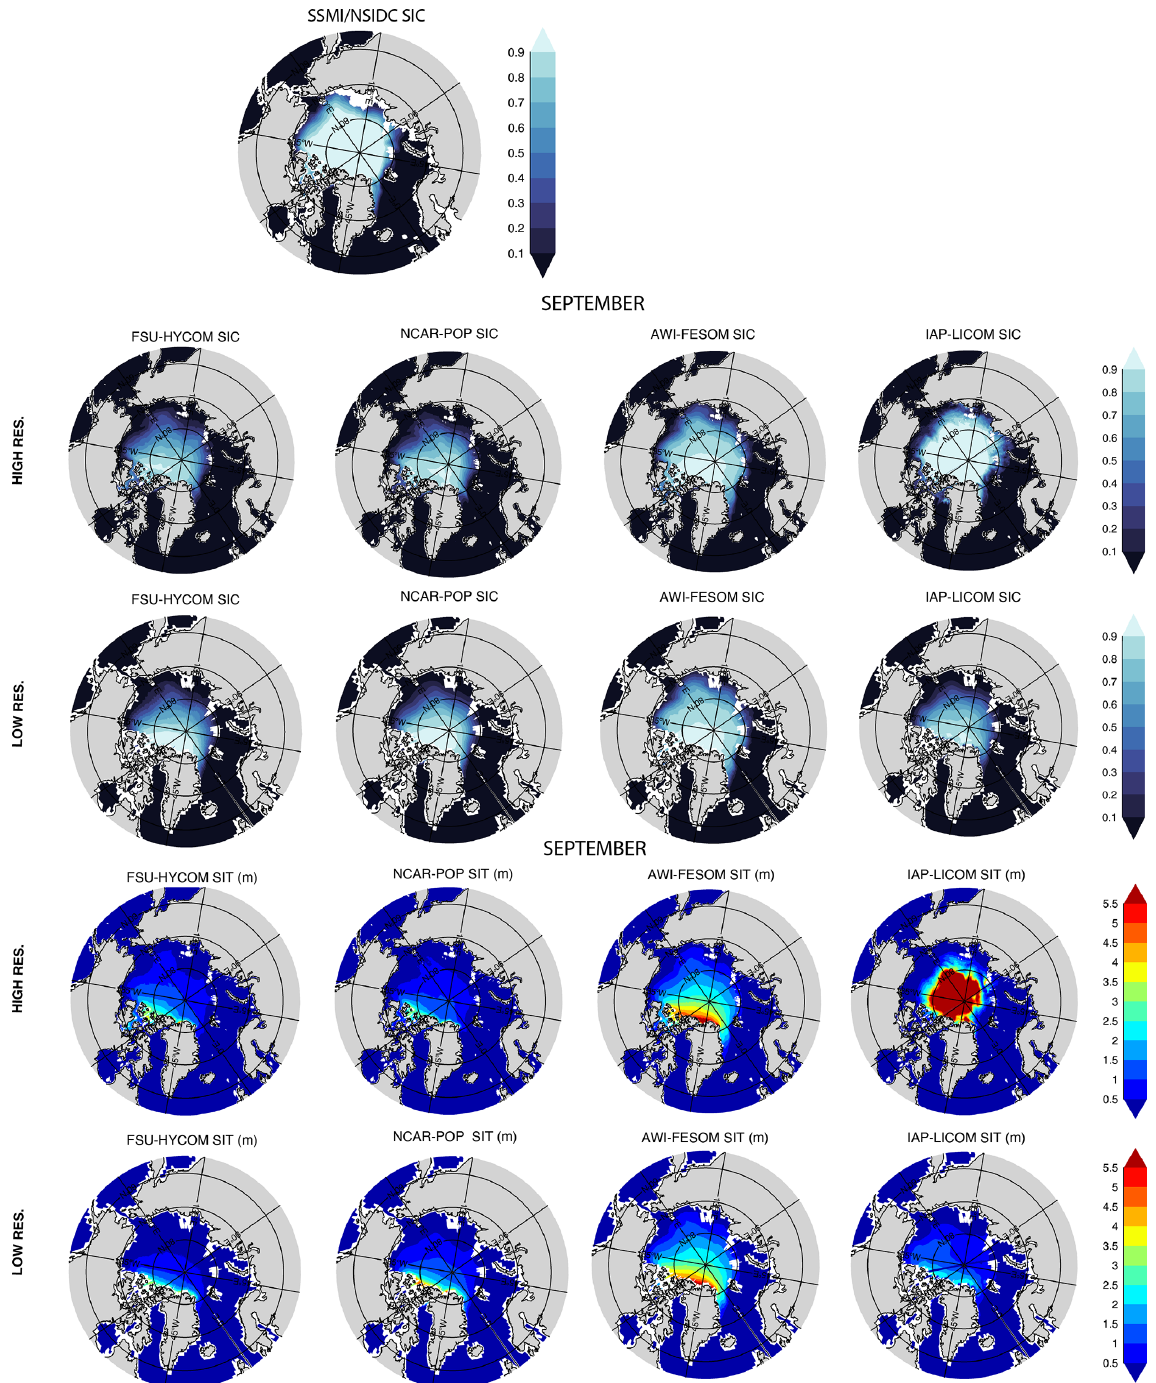
Figure 30. Northern Hemisphere summer mean (September) sea ice concentration (SIC) and thickness (SIT). Top panel: 1980–2018 SIC from passive microwave satellites (summer SIT not available from ICESat). Lower panels: 1980–2018 modeled SIC and